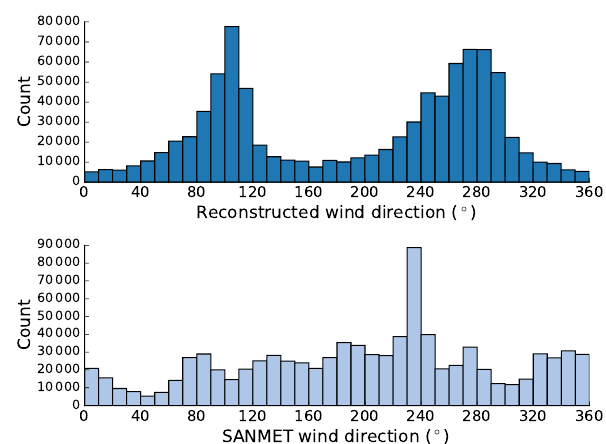
Figure 25. Comparison between SANMET and reconstructed wind direction during the complete VL1